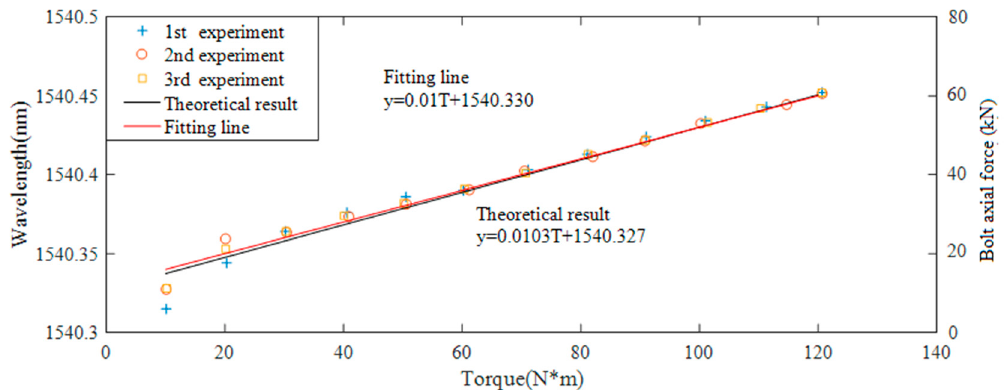
Figure 12. The comparison of theoretical and experimental results.